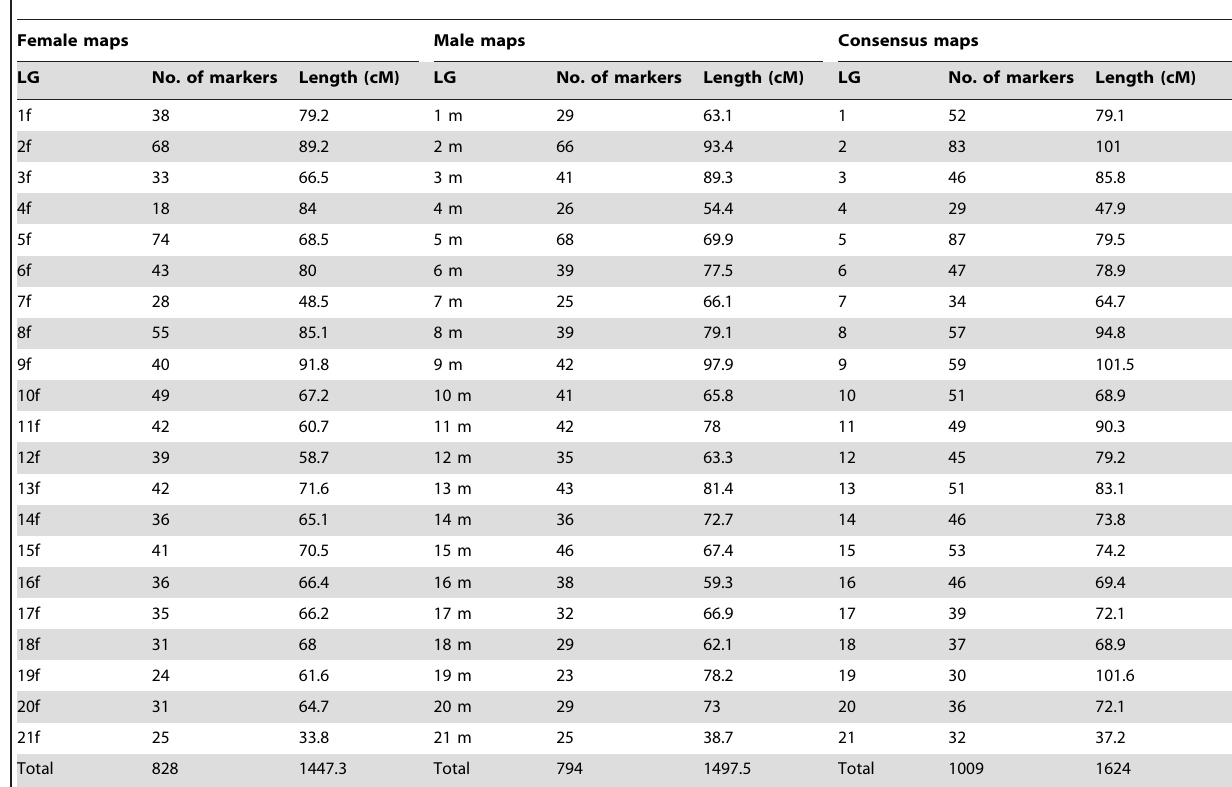
Table 1. The characterization of linkage groups of half-smooth tongue sole.